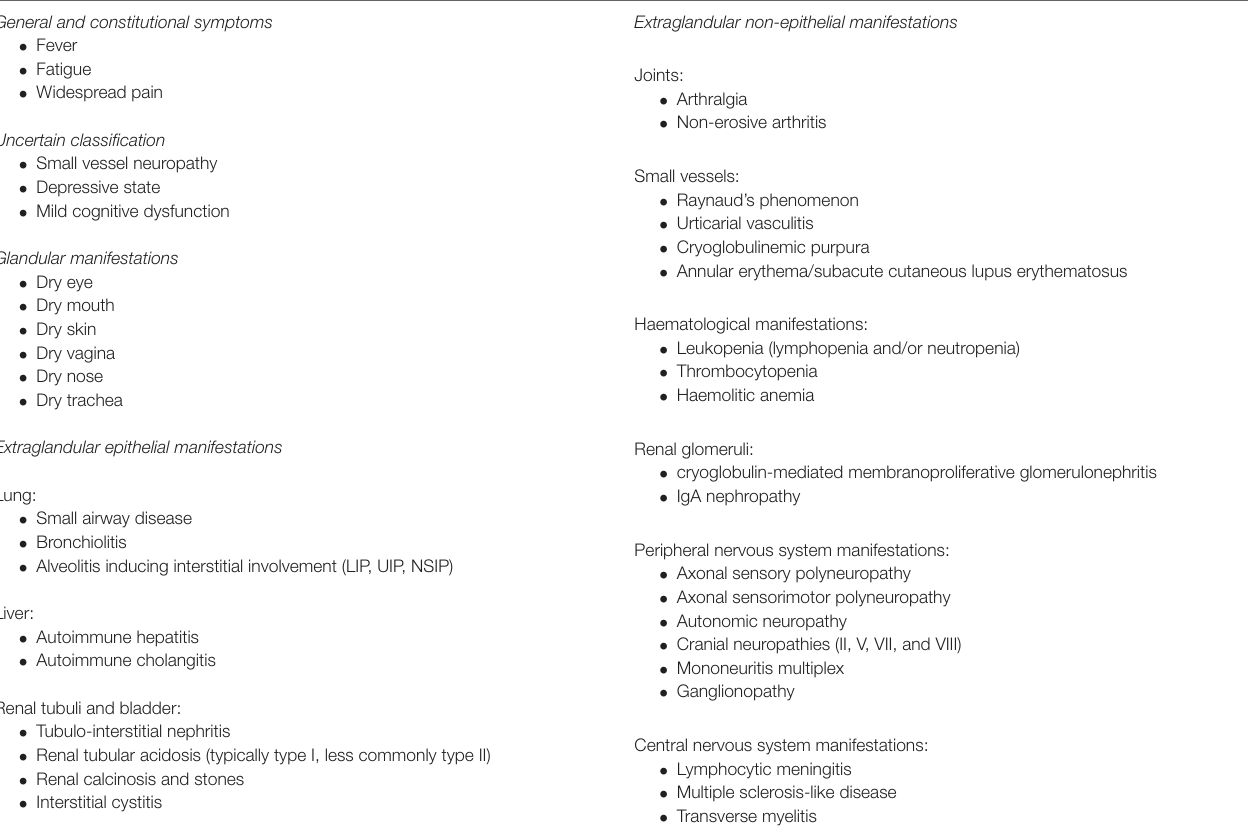
TABLE 2 | Clinical features of pSS subdivided in glandular, extraglandular epithelial, and extraglandular non-epithelial manifestations. General and constitutional symptoms •